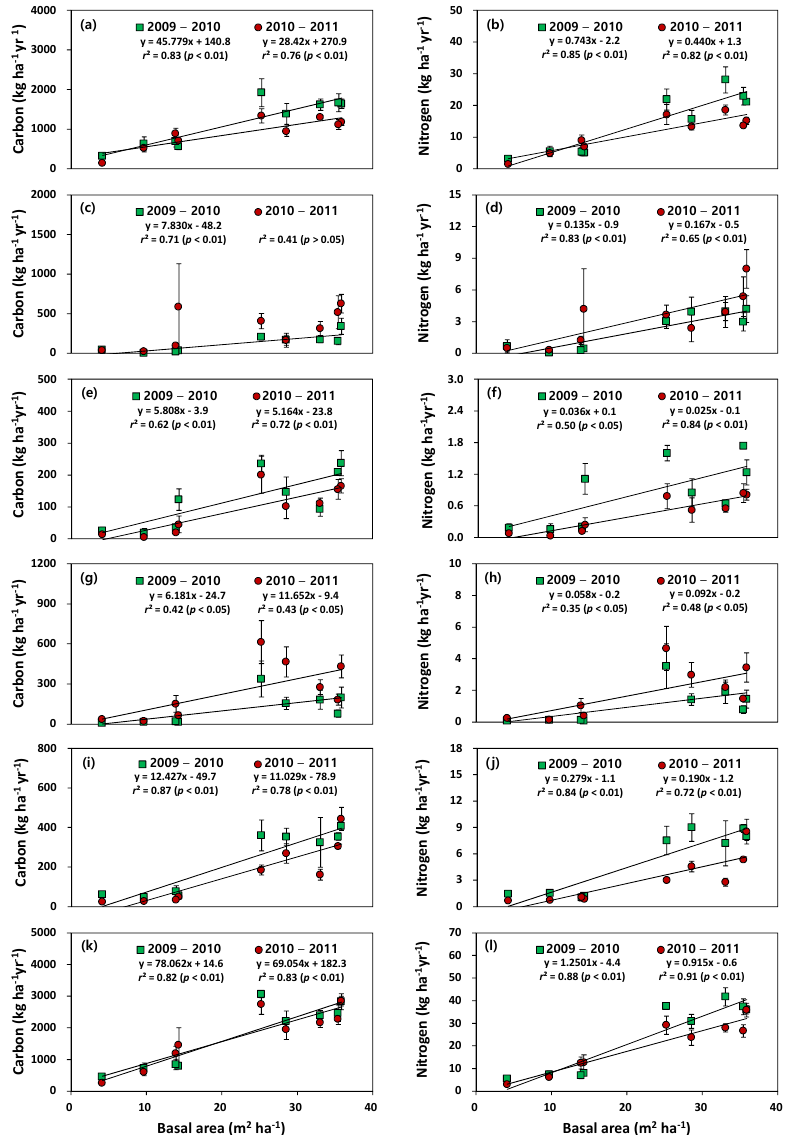
Figure 3. Relationships between basal area and carbon and nitrogen inputs through litterfall components [( a , b ) needle, ( c , d ) branches, ( e , f ) bark, ( g , h ) reproduction, ( i , j ) miscellaneous, ( k , l ) total] in pine wilt disease disturbed stands ( n = 3). Vertical bars represent standard error.